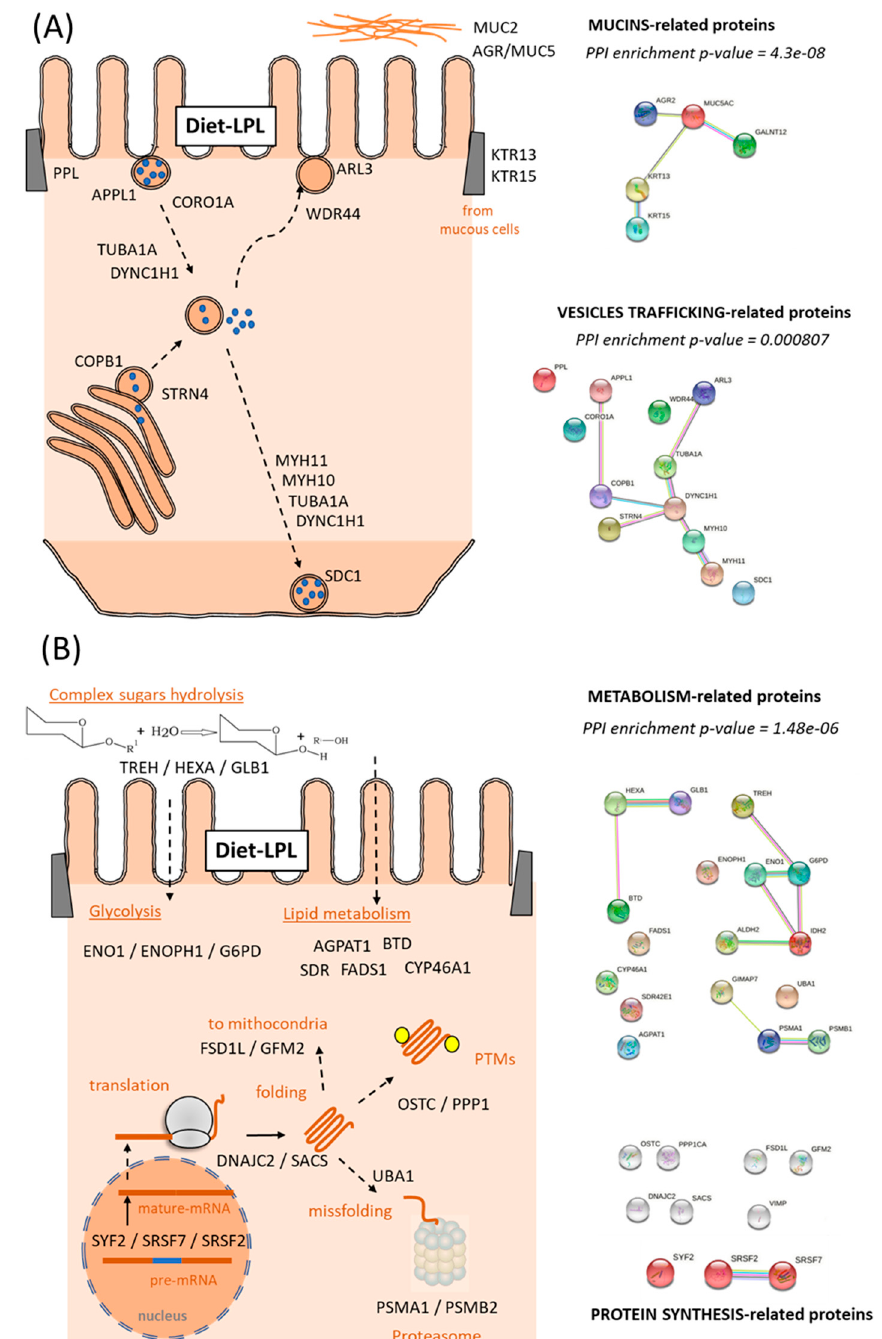
Figure 4. Diagrams of the functional pathways upregulated by the LPL-diet in the salmon intestine. (A) Vesicles Trafficking and Extracellular Matrix and (B) Metabolic-related proteins. Putative relationships of the upregulated DEPs from their main function (UniProtKB). For each cluster, the protein–protein interaction (PPI)-enrichment p -values are shown. Details of each DEP are described in the Supplementary File S5.